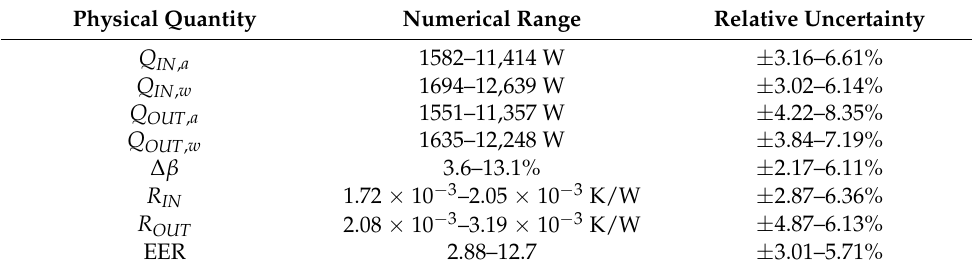
Table 3. Uncertainty of the main parameter variables.